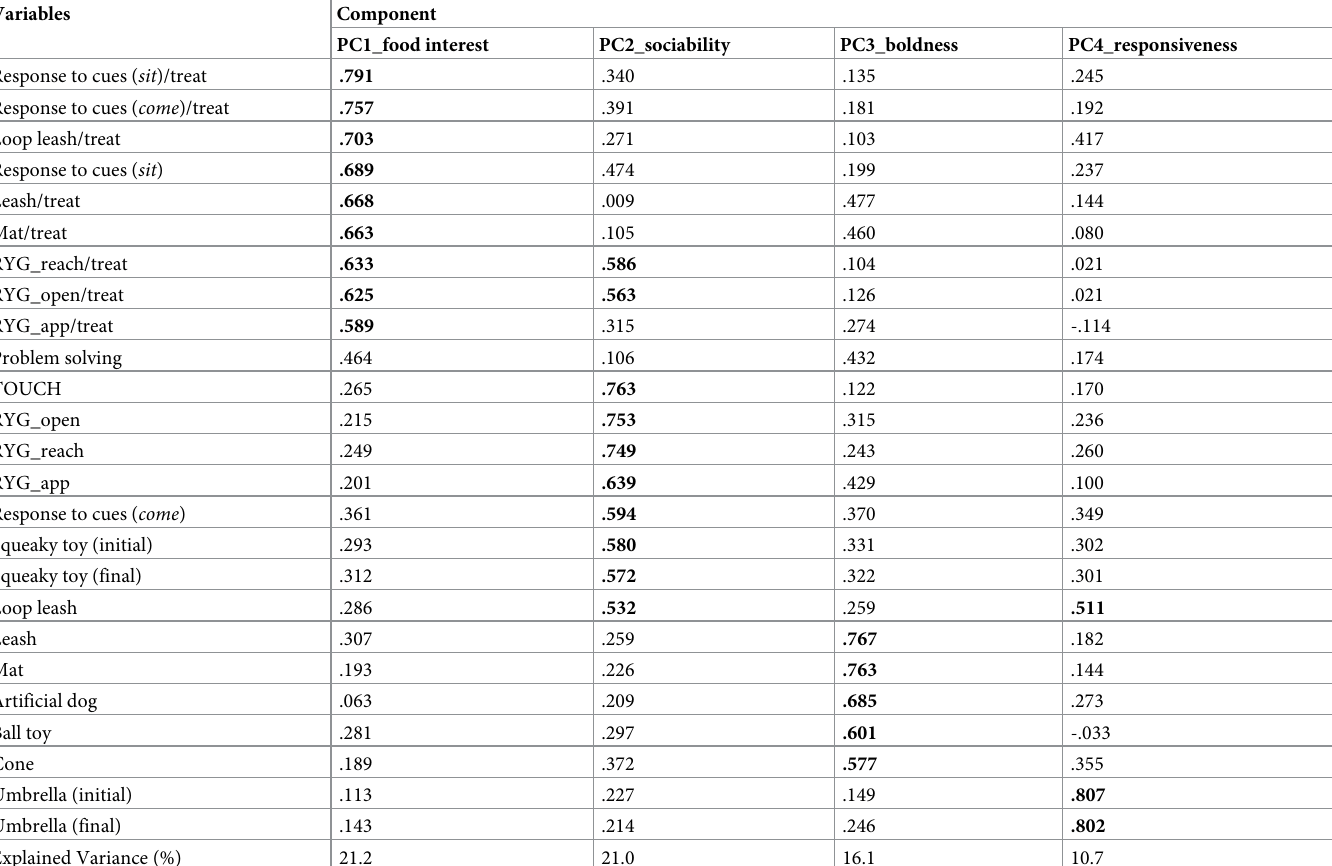
Table 3. Principal components extracted by the principal component analysis (PCA). Loadings higher than 0.50 are in